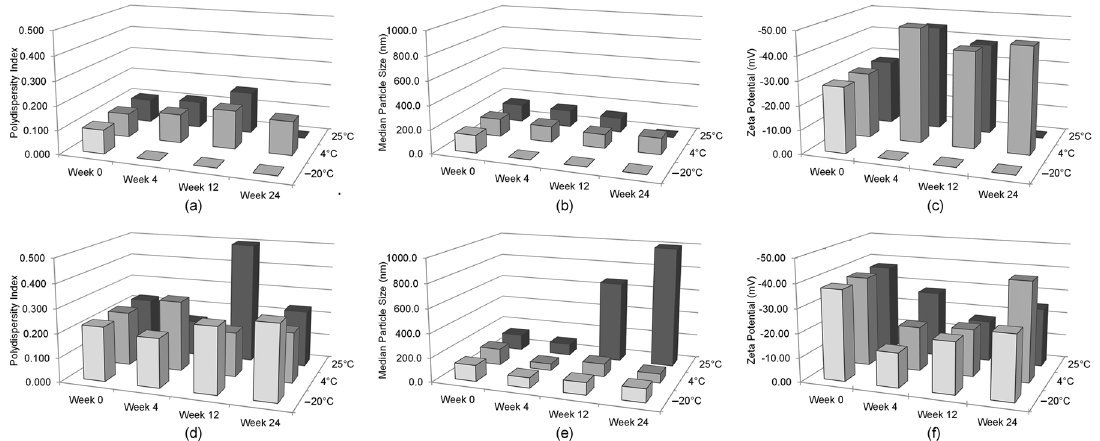
Figure 5. Physical characteristics of the liquid and lyophilized GT3 NE formulations over time. Polydispersity index of ( a ) liquid and ( d ) lyophilized GT3 NE, particle size of ( b ) liquid and ( e ) lyophilized GT3 NE, and zeta potential of ( c ) liquid and ( f ) lyophilized GT3 NE. For those samples which could not be analyzed due to phase separation (e.g., the liquid GT3 NE stored at − 20 °C), the measurements are listed as zero on the bar charts. The increase in shades of gray correspond to increase in temperature.